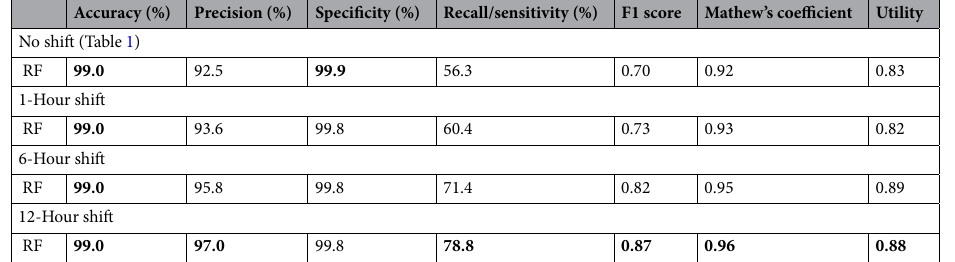
Table 3. RF accuracy measures for early sepsis detection. The results from Table 2 are included in this table as the “no shift” (e.g. zero shift) to put the sepsis detection at clinical determination time versus early sepsis detection in context. Utility is the additional evaluation metric 5 that measures how well the model is doing at early sepsis detection. Highest values obtained are in